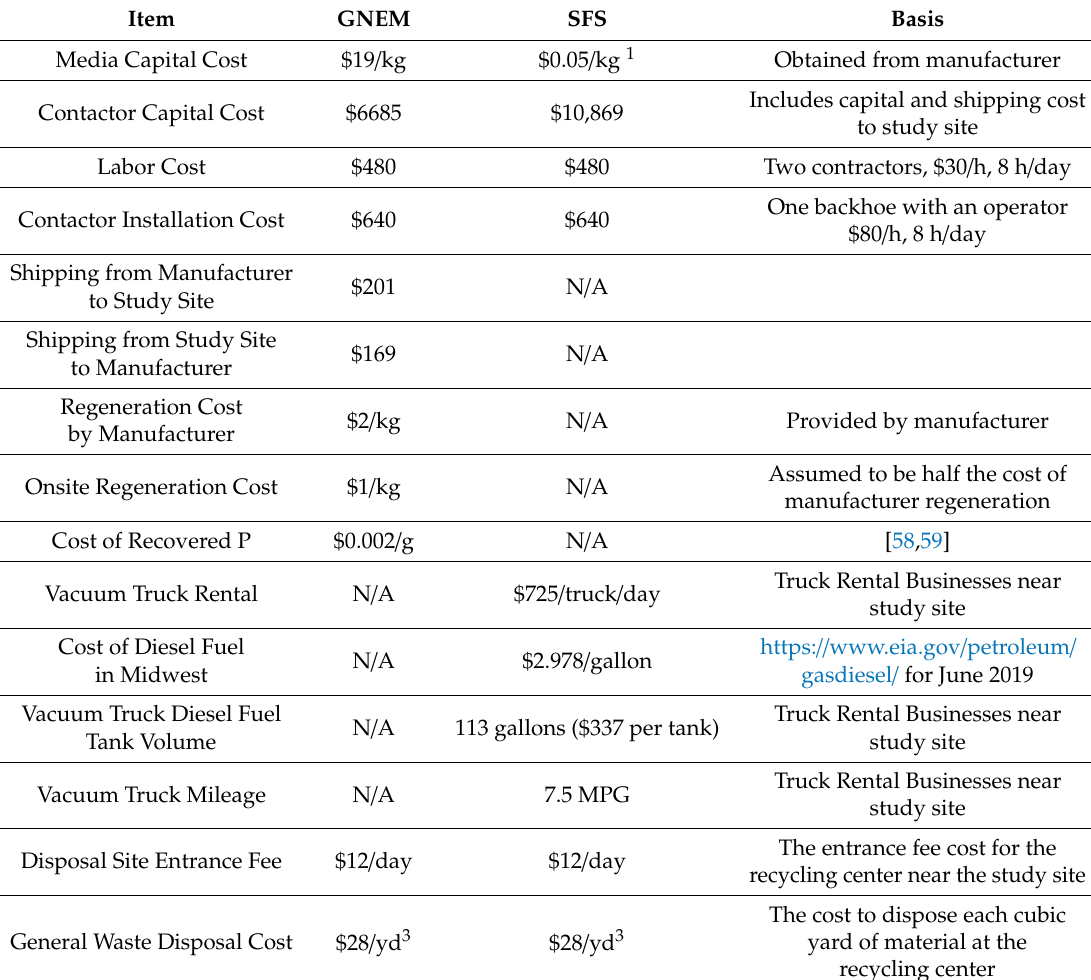
Table 9. Costs associated with PSM implementation